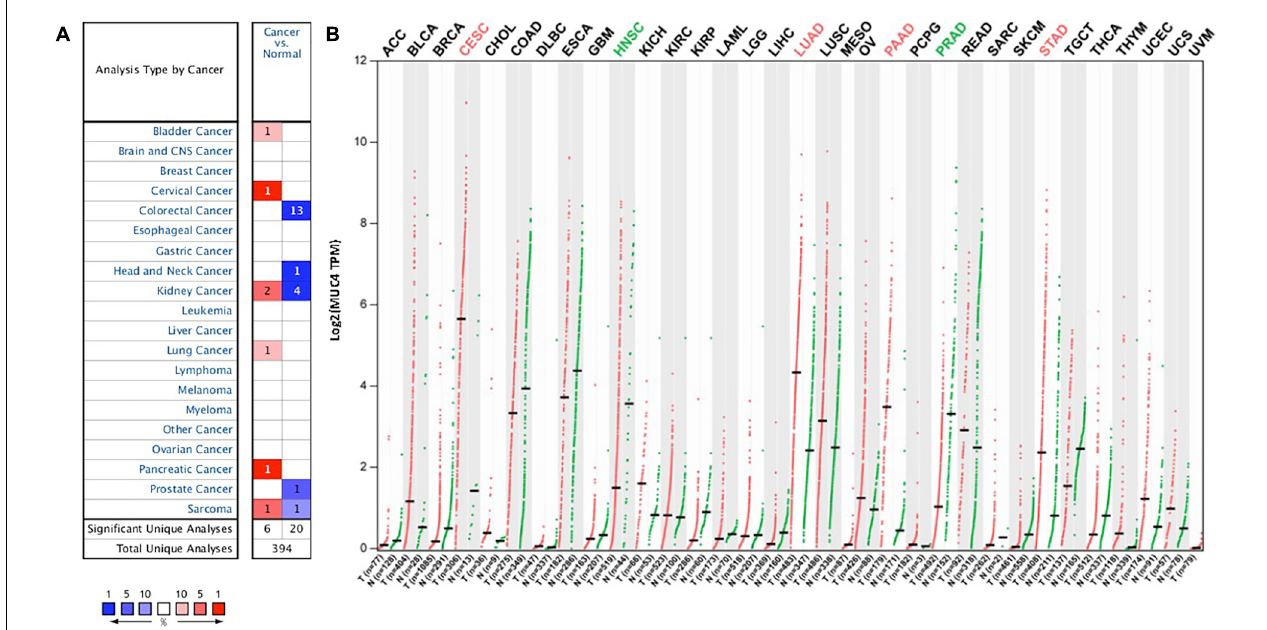
FIGURE 1 | MUC4 mRNA expression levels in pan-cancer. (A) Upregulated or downregulated expression of MUC4 in tumor tissues, compared with normal tissues of each cancer type in Oncomine. Red signifies the gene’s overexpression in the analyses represented by that cell in the table; blue represents the gene’s underexpression in those analyses. Intensity of color signifies the best rank of that gene in those analyses. The number in each cell represents the number of analyses that meet your thresholds within those analyses and cancer types. (B) MUC4 expression profile across all tumor samples and paired normal tissues in GEPIA2. Each dot represents a distinct tumor or normal